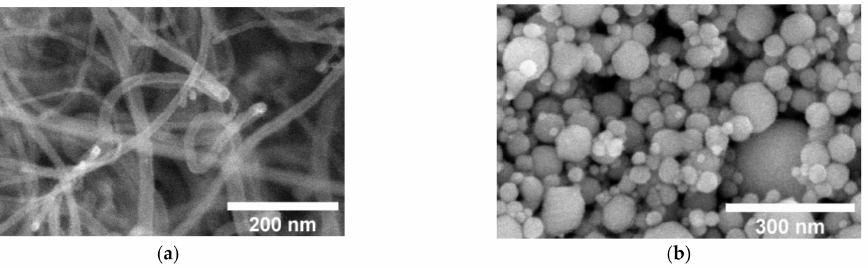
Figure 1. Scanning electron microscopy micrographs of MWCNTs ( a ) and Ni@C (carbon-coated Ni) ( b ) nanoparticles.